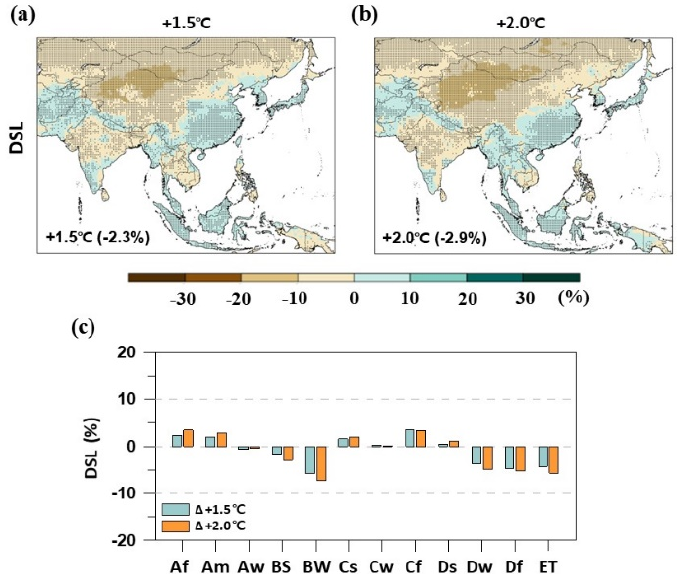
Figure 5. Spatial distribution of relative changes in dry spell length (DSL) under ( a ) 1.5 ◦ C and ( b ) 2.0 ◦ C global warming compared to reference period (REF) (unit: %). The values in parentheses indicate the change in the area-averaged mean over the Asian monsoon region. ( c ) Relative changes in DSL for individual 12 climate zone under 1.5 ◦ C and 2.0 ◦ C global warming compared to reference period (REF) (unit: %).